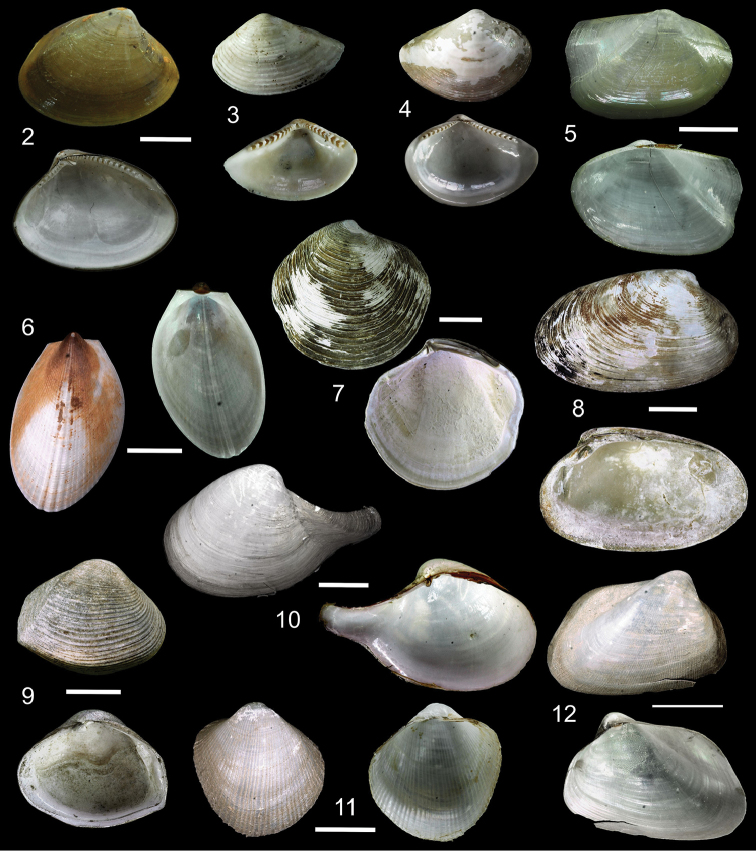
2 Exterior and interior views of Ennuculapanamina3Jupiterialobula (total length = 4.2 mm) 4Neilonellacf.atossa (total length = 5 mm) 5Malletiagoniura6Limatulacf.saturna7Lucinomaheroica8Calyptogenacf.gallardoi9Carycorbula sp. 10Cuspidariapanamensis11Dallicordiaalaskana12Lyonsiellacf.magnifica. Scale bars: 2, 5, 6, 9, 11 5 mm. 7, 8, 10, 12 10 mm.